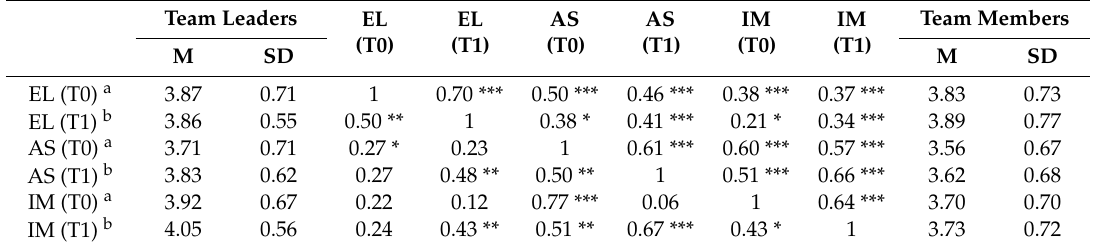
Table 3. Means (M), Standard Deviations (SD), Intercorrelations